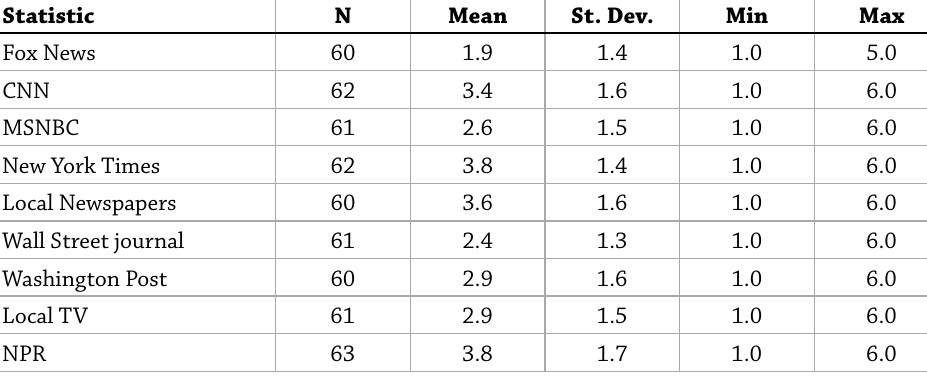
Table 2: Descriptive Statistics of Media